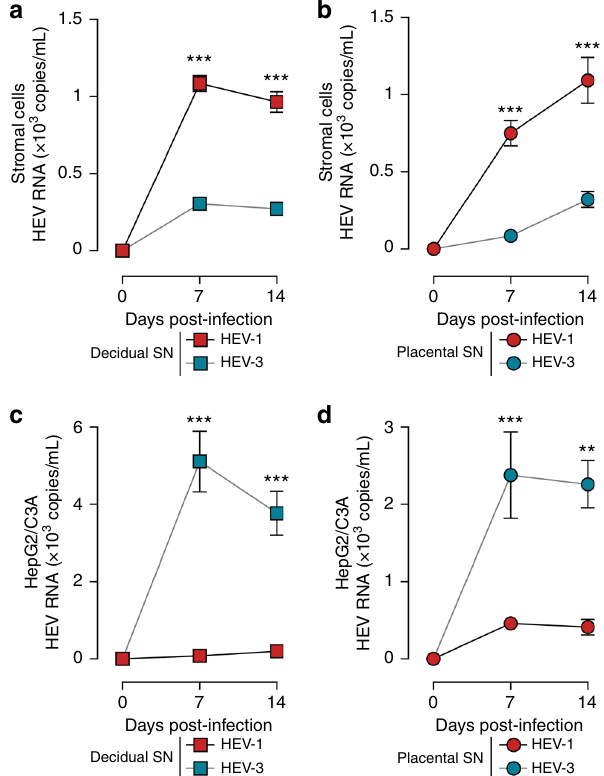
Fig. 8 HEV-1 replication in explants derived from the decidua and placenta generates infectious progeny particles. Freshly isolated stromal cells a , b , or the HepG2/C3A cell line c , d , were challenged with culture supernatants (SN) from either HEV-1 (red), or HEV-3 (cyan) infected decidual a , c , or placental b , d explants. Viral replication was then followed over a 2-week period by RT-qPCR. Data represent means values ± S.E.M. of six independent donors. * denotes a statistical comparison made between HEV-1 and HEV-3 infected cells. ** P < 0.01; *** P < 0.001 by two-way ANOVA with Bonferroni post hoc